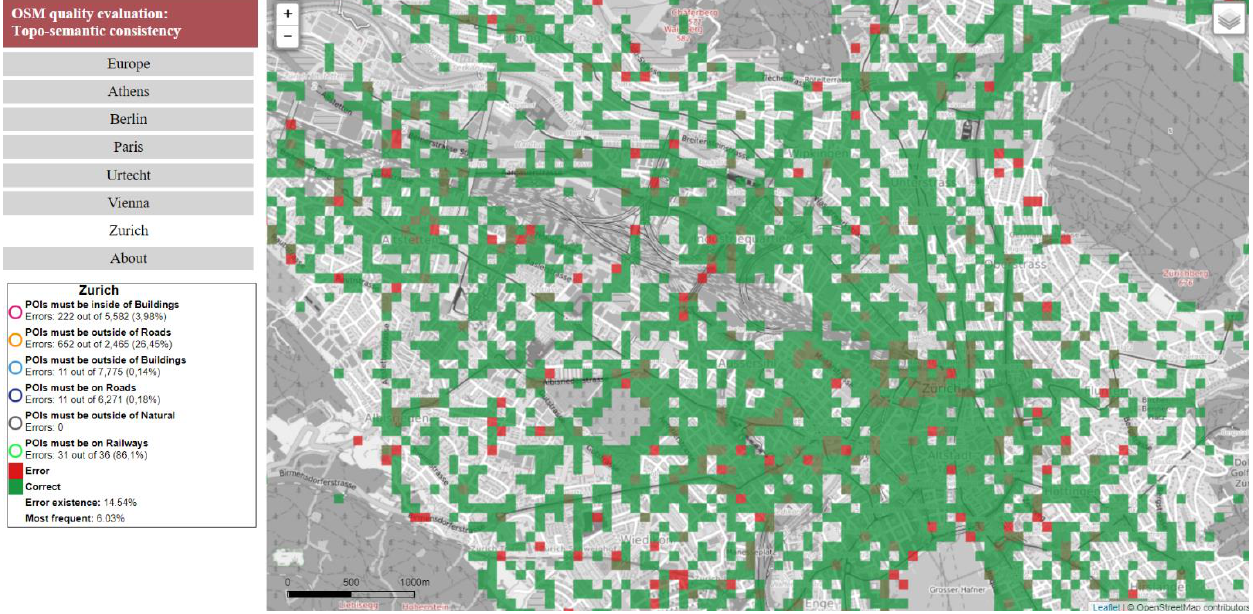
Figure 9. “Consistency Grid (most frequent)” for Zurich, portrayed on the OpenStreetMap B&W basemap.